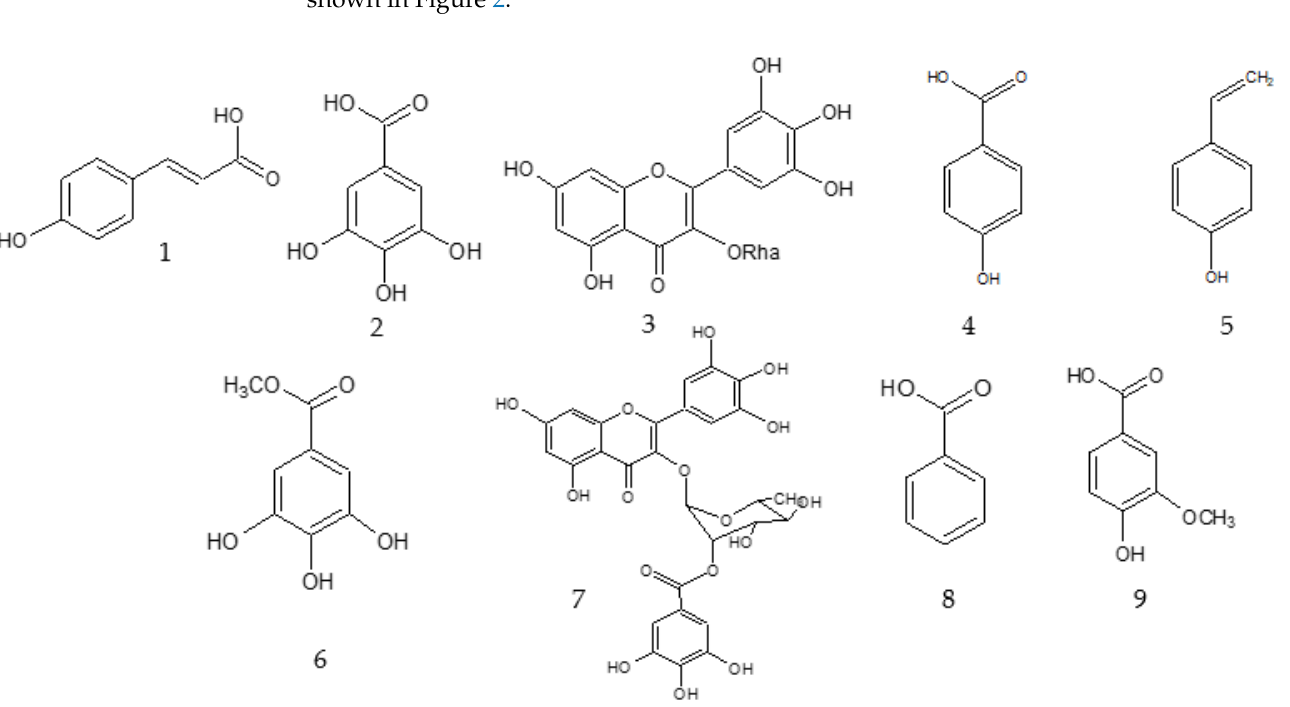
Figure 2. Chemical structure of the compounds ( p ‐ coumaric acid ( 1 ), gallic acid ( 2 ), myricetin ‐ 3 ‐ O ‐ rhamnopyranoside ( 3 ), p ‐ hydroxybenzoic acid ( 4 ), 4 ‐ vinyl phenol ( 5 ), methyl gallate ( 6 ), myricetin ‐ 3 ‐ O ‐ (2 ″‐ O ‐ galloyl) ‐α‐ rhamnopyranoside ( 7 ), benzoic acid ( 8 ), and vanillic acid ( 9 )) identified in the cytotoxic Inga species.